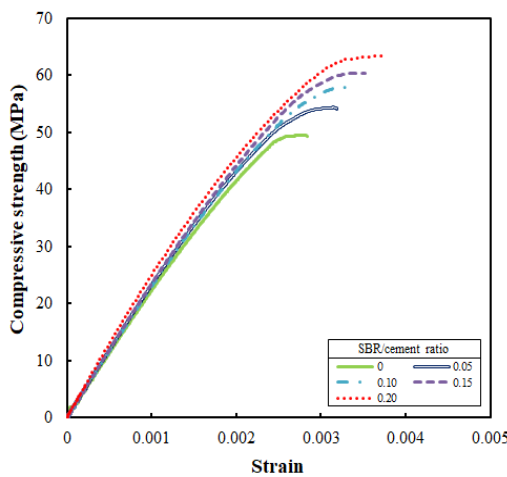
Figure 4. Stress–strain diagrams for different SBR/cement ratios.